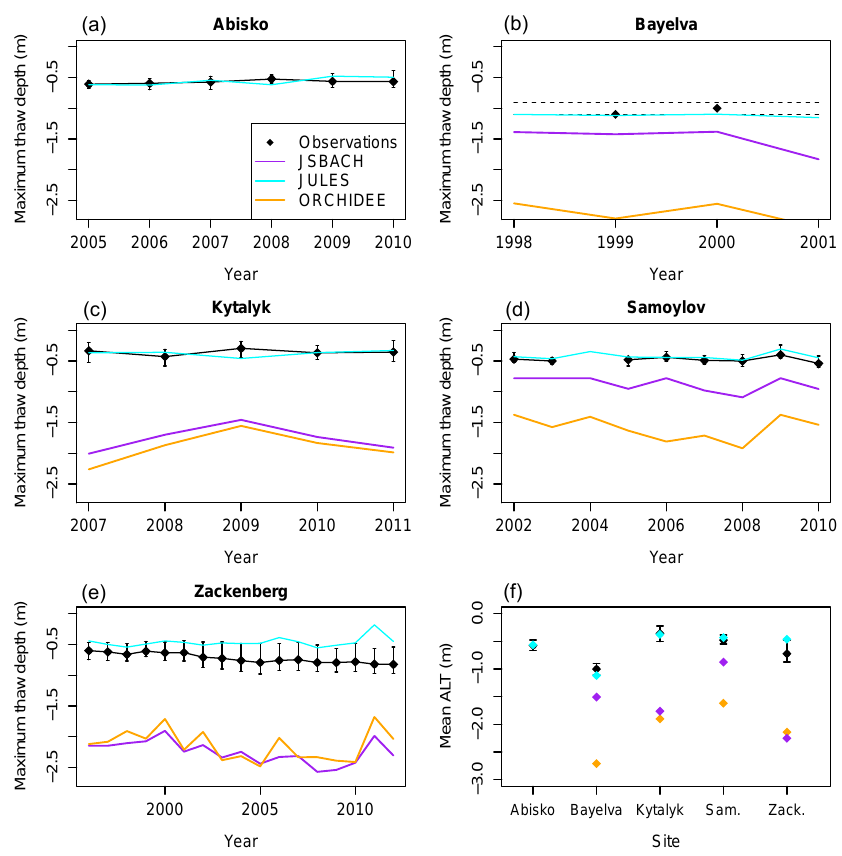
Figure 4. Maximum summer thaw depth (active layer) over a number of years at each site, comparing observations and models. Dotted lines in panel (b) represent the range of observed estimates. For all other panels, CALM grids are used, and the error bars show the full range of measured values in the grid. In panel (f) the error bars show the mean of the upper and lower limits from the previous